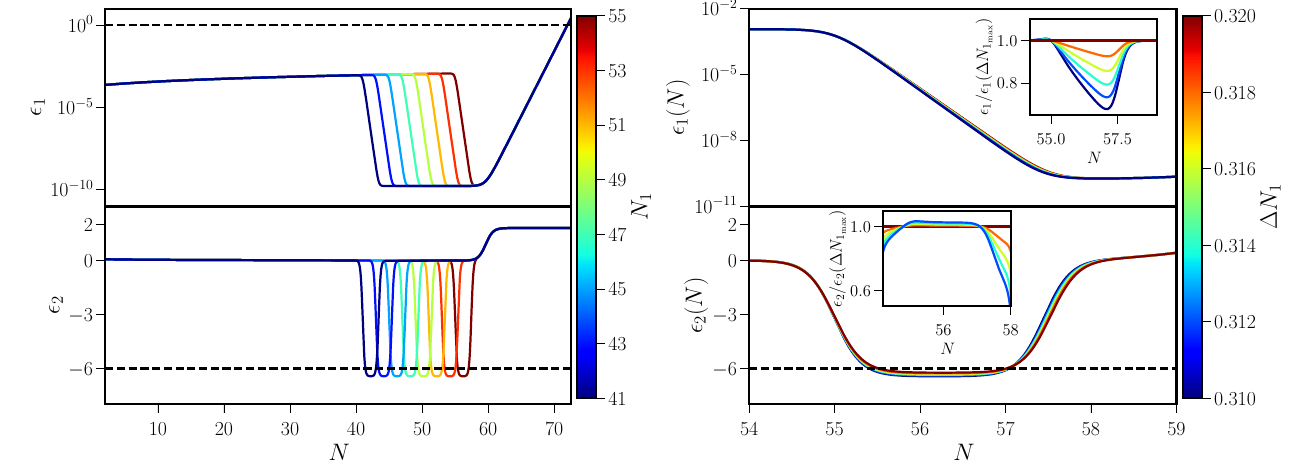
Figure 4. The behavior of the first two slow roll parameters (cid:101) 1 (on top) and (cid:101) 2 (at the bottom) are presented for the scenario wherein (cid:101) 1 ( N ) is given by Equation (33). We have plotted the slow roll parameters over a range of N 1 varied in steps of two e -folds (on the left) and ∆ N 1 (on the right ). While the effects of the variation in N 1 are evident in the figure, the effects of the variation of ∆ N 1 are not so visible. Hence, we have included insets (on the right ) to highlight the minor differences that arise in the parameters. Clearly, the slow roll parameters in the reconstructed scenario behave broadly in the same fashion as in the six, specific inflationary models we have